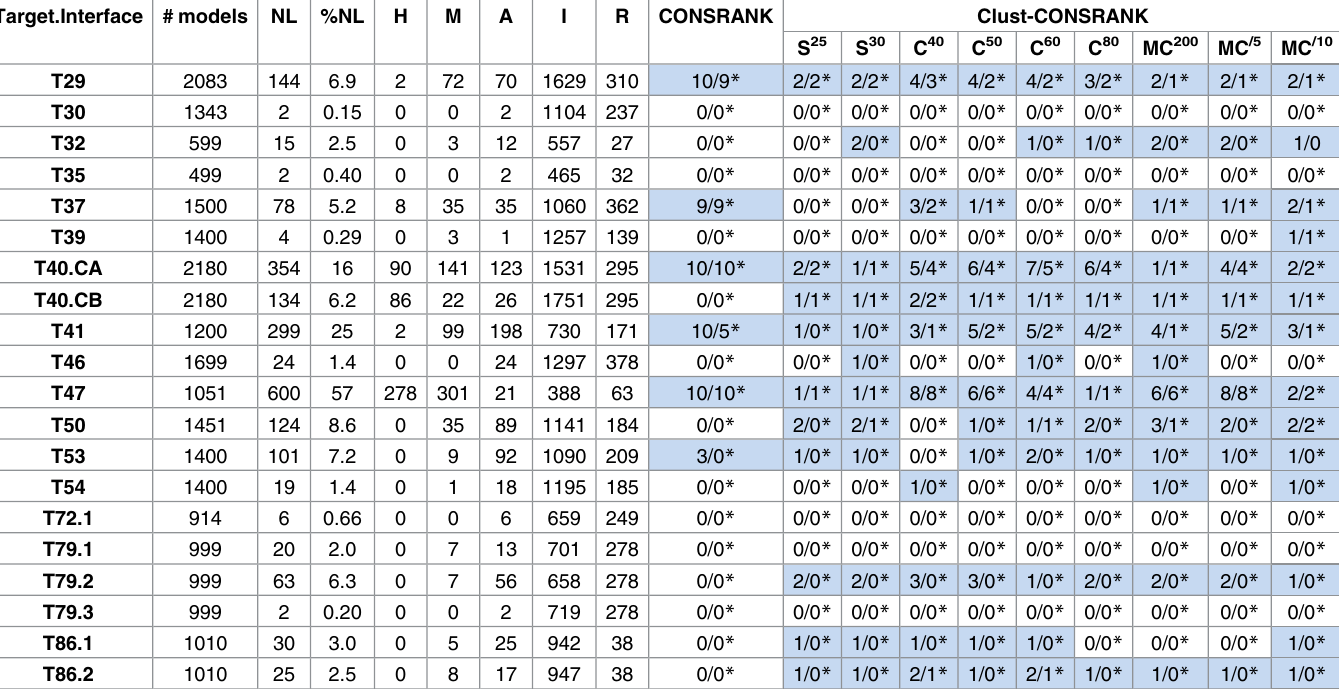
Columns 1–9: features of analysed targets: H, M, A, I and R indicate the high, medium-quality, acceptable, incorrect and removed models. NL stays for native-like, that is the sum of H, M and A models. Columns 10–19: results of the scoring with original CONSRANK scoring algorithm and with different combined Consrank-clustering approaches. In each column the total number of NL/H+M * models per target/interface is reported. “S” stays for Single, “C” for Complete, with numbers indicating the corresponding thresholds used in the clustering; MC 200 , MC /5 and MC /10 ” indicate results of a clustering approach with a maximum number of clusters fixed to 200 and to 1/5 and 1/10 of the total number of models per target, respectively (see Methods) Positive results are highlightedin